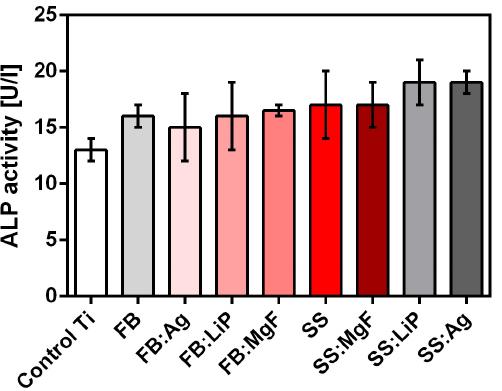
Figure 12. The e ff ect of simple and doped FB and SS thin fi lms on the alkaline phosphatase (ALP), Figure 12. The effect of simple and doped FB and SS thin films on the alkaline phosphatase (ALP), 48 h after incubation. 48 h after incubation.